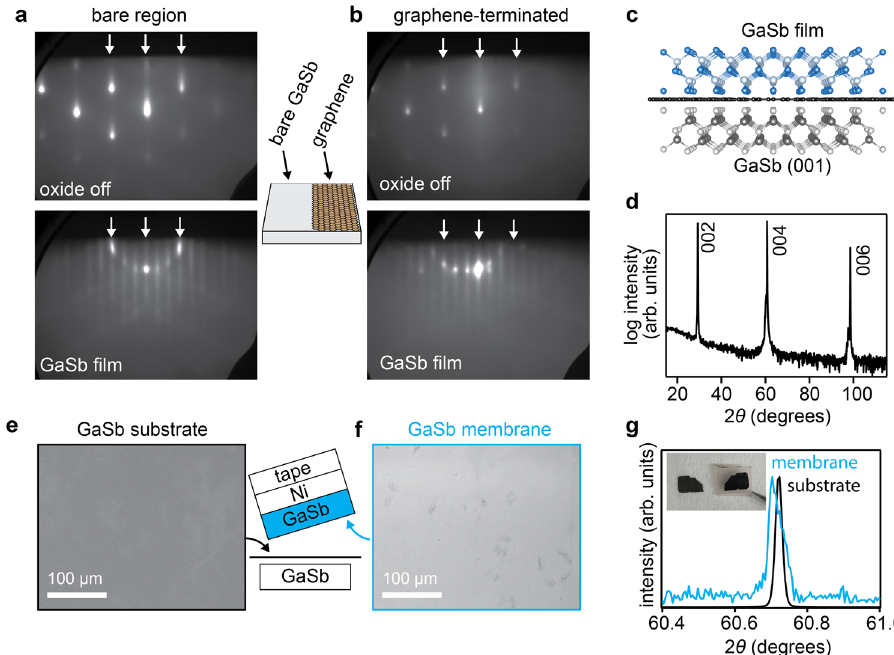
Fig. 1 Epitaxy and exfoliation of GaSb on graphene-terminated GaSb (001). a – d GaSb epitaxy on a GaSb (001) substrate that is half covered with graphene. a Re fl ection high energy electron diffraction (RHEED) patterns along a ½ 1 (cid:1) 10 (cid:2) azimuth, tracking direct epitaxy on the exposed GaSb region. RHEED after the oxide off step shows a bright three-dimensional pattern. After 75 nm of fi lm growth, an atomically smooth smooth ring of spots RHEED pattern is recovered. b RHEED patterns tracking oxide desorption and growth on the graphene-terminated half of the substrate. c Schematic of the heterostructure. (d) X-ray diffraction pattern of the GaSb fi lm grown on the graphene-terminated side of GaSb (001). e – g GaSb membrane exfoliation using a Ni stressor layer. e SEM image of the under side of the exfoliated GaSb membrane. The inset schematic illustrates the exfoliation. f SEM images of the substrate after exfoliation. g X-ray diffraction patterns of the 004 re fl ection for the exfoliated GaSb membrane (blue) and the GaSb substrate (black). Insert: example photo of the substrate (left) and GaSb membrane (right) after exfoliation. Membrane dimensions are approximately 10 mm by 6